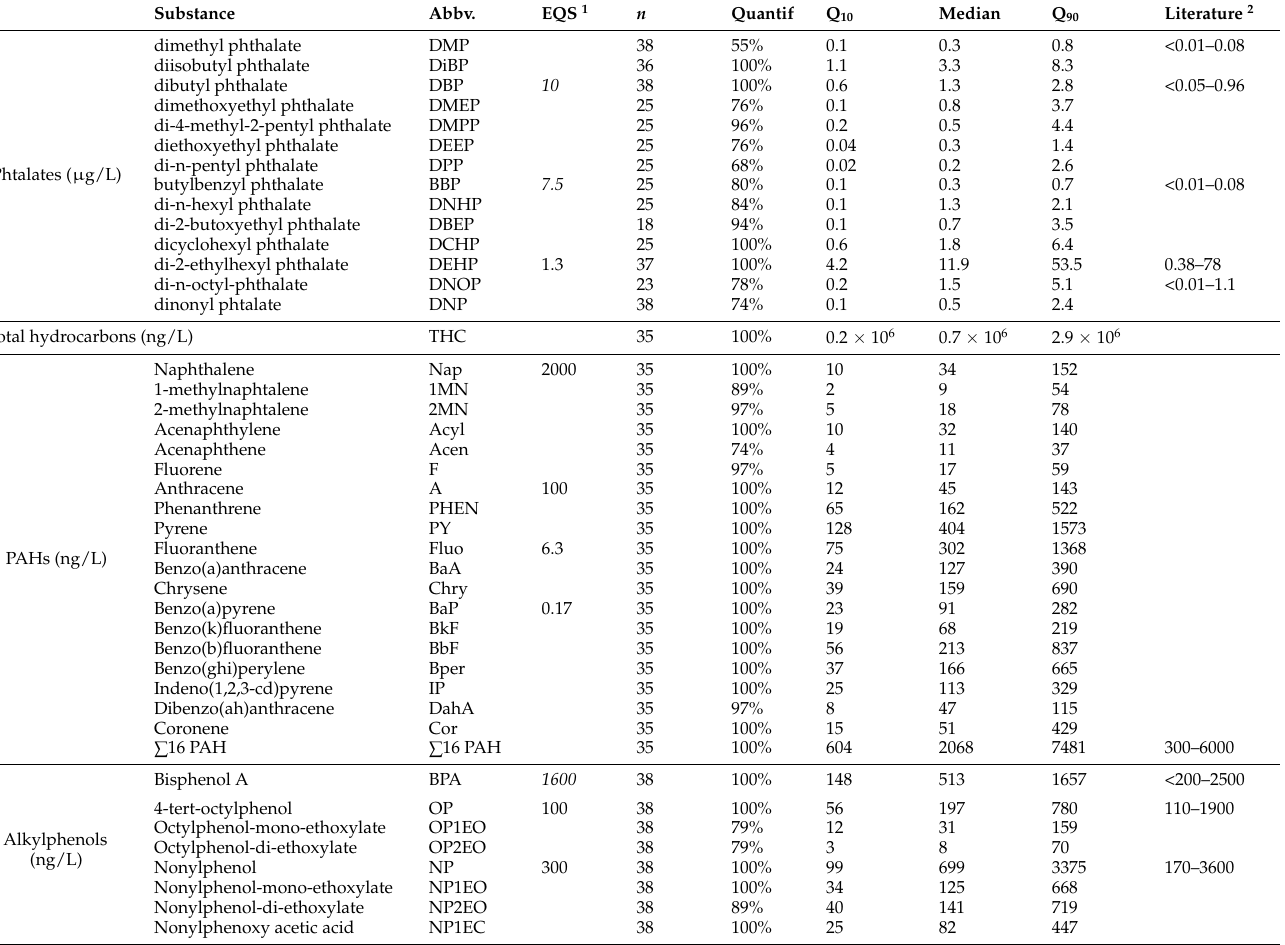
Table 6. Organic micropollutants (group 3) analyzed in the runoff, quantification frequency and range of quantified total EMC